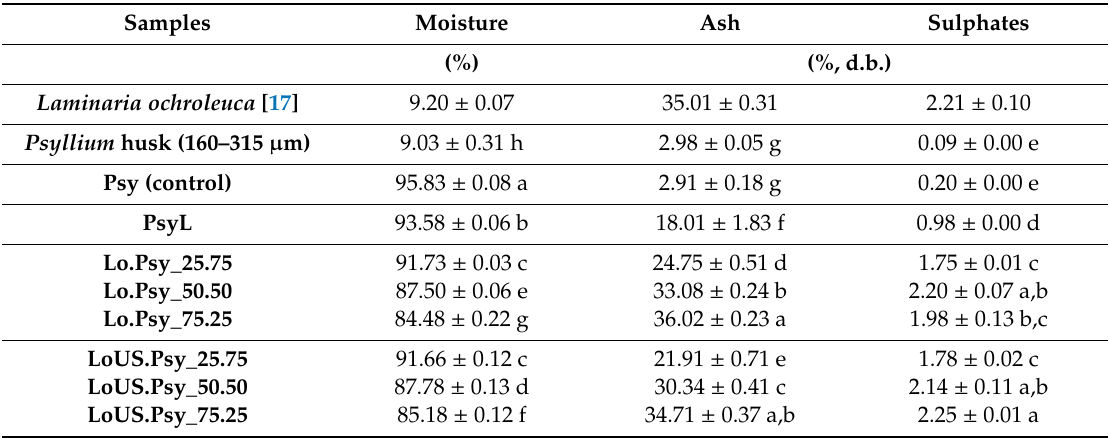
Table 1. Moisture, ash, and sulfate content of Laminaria ochroleuca , Psyllium husk, and the developed gels. Samples Moisture Ash